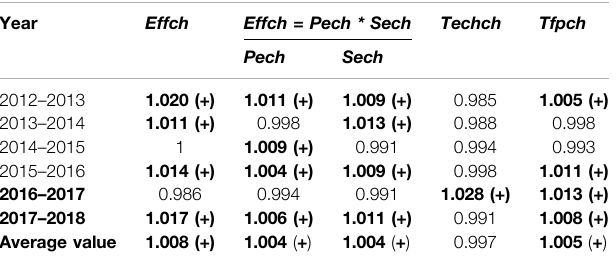
TABLE 3 | Averaged decomposed WUE of various regions in Guangdong Province from 2012 to 2018. Region